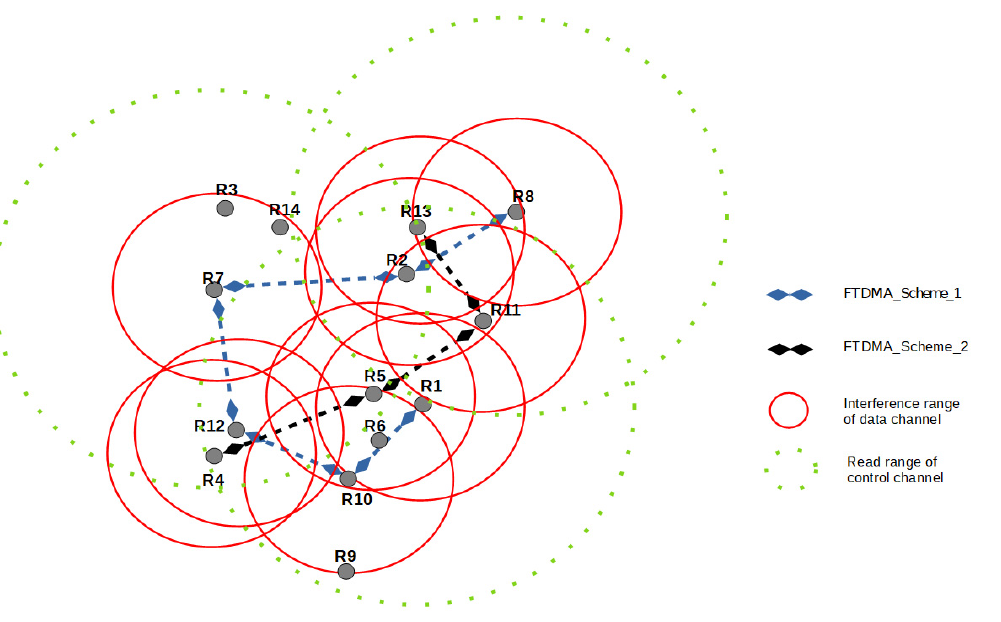
Figure 6. The process of creating FTDMA schemes . Using our algorithm, we manage three frequencies and time slots. As a result, we can define FTDMA_Scheme_1 as the set of readers R1, R10, R12, R7, R2, and R8 using the first pair resource (freq1 and TS1). In addition, FTDMA_Scheme_2 is composed of R13, R11, R5, and R4, which use the second pair resource (freq2 and TS2). The readers that do not join the latter FTDMA_Scheme_2 must use the last frequency using CSMA. Figure 6 describes the communication process used by the protocol in this example. We present the process of the algorithm for different situations of readers (R1, R2, R3, R8, R10, R13) in Appendix A.